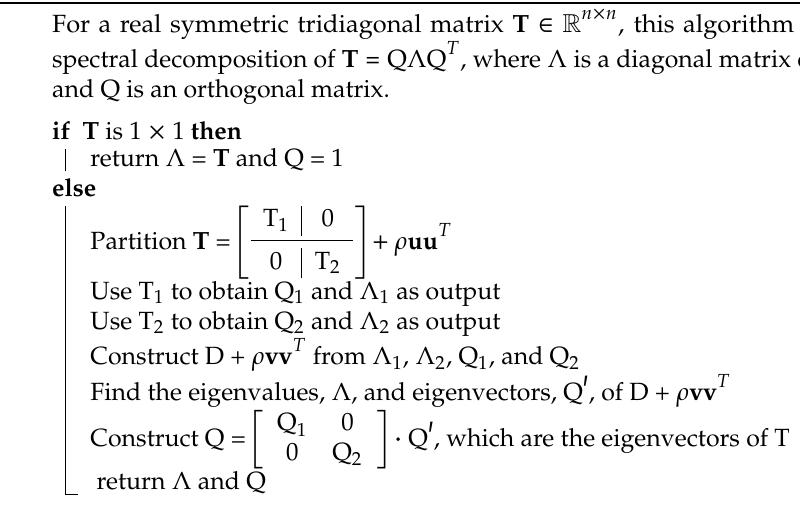
Algorithm 1: The tridiagonal Divide-And-Conquer